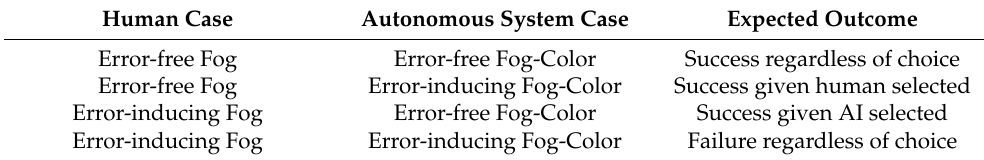
Table 8. Human–AI pair